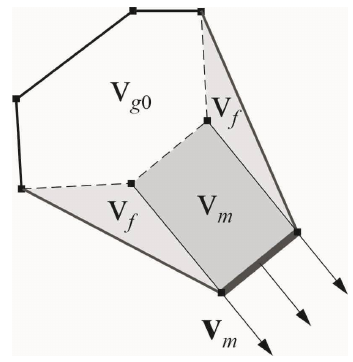
Figure 5. Scheme of facet migration.